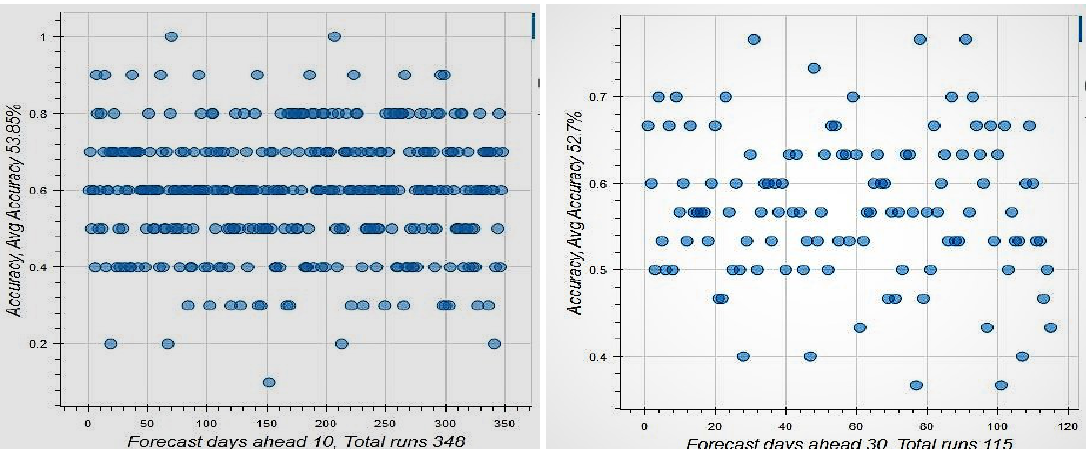
Figure 8. Forecast period average accuracy, where the look back period is L = 30 days and the forecast period is F = 10, 30 days. Forecast period average accuracy is 64% for F = 10 days and 77% for F = 30 days, both well over 50% as can be seen from the number of points in Figure 8 that lie above the 0.5 level on the y-axis. The overall accuracy is slightly over 50%, i.e., 53.9% for F = 10 days and 52.7% for F = 30